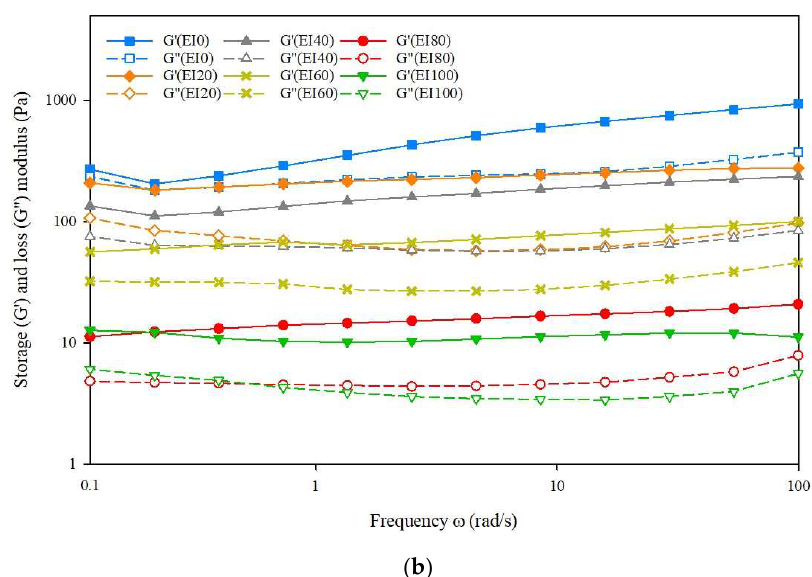
Figure 1. Rheological properties (apparent viscosity ( a ), dynamic viscosity ( b )) of emulsion prepared with the interaction between porcine myofibrillar protein and extracted edible insect protein. Porcine myofibrillar protein was substituted by edible insect protein at 0, 20, 40, 60, 80, and 100% (EI0, EI20, EI40, EI60, EI80, and EI100, respectively).